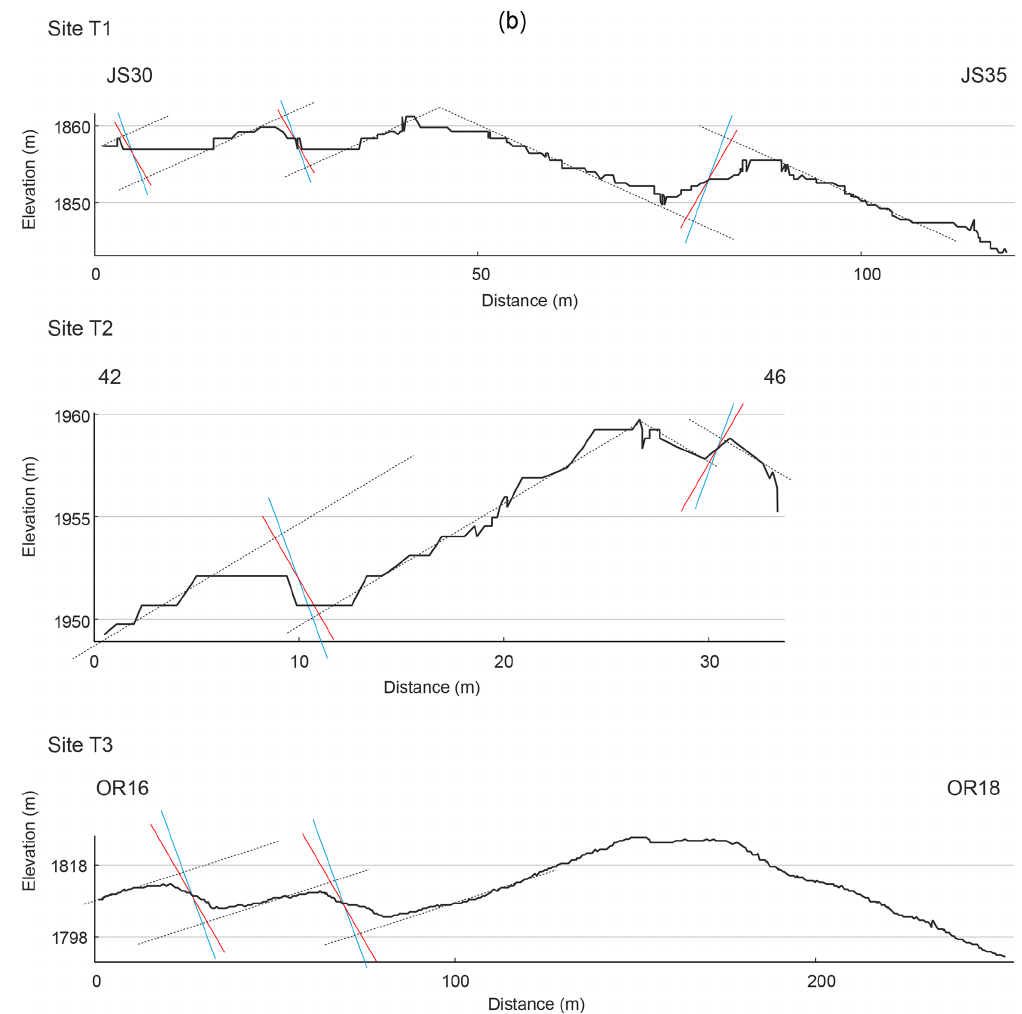
Figure 8. (b) Determination (dotted lines) of fault traces (continuous lines) measured at the three Tatra study sites, assuming fault dips of 60 ◦ (red) and 70 ◦